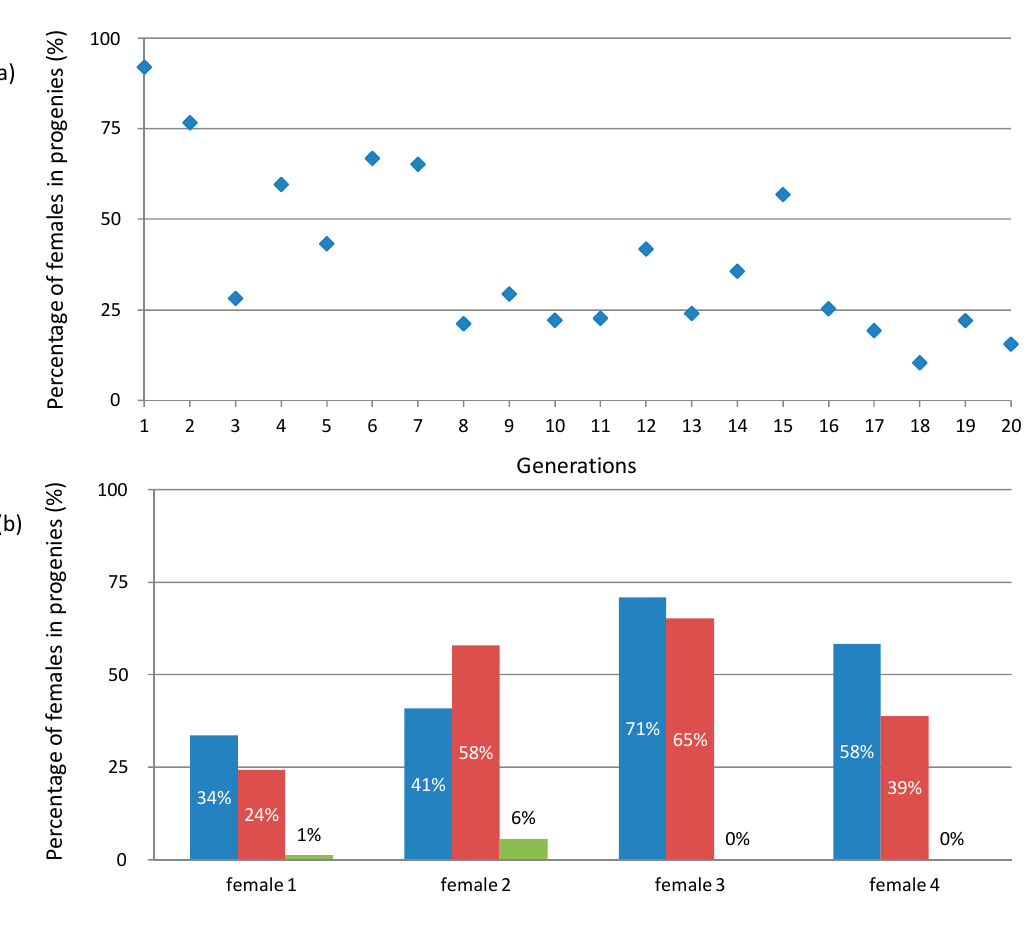
Figure 4. Variation in female percentage in progenies of Armadillidium vulgare females carrying the f element at the genealogical level. ( a ) Variation in an isofemale line across 20 generations (unpublished results from our laboratory line WXf from 1990 to 2010). ( b ) Variation in three successive progenies of four females (1–4) mated with single males (data from [58]). The first, second and third progenies of each female are shown in blue, red and green, respectively.